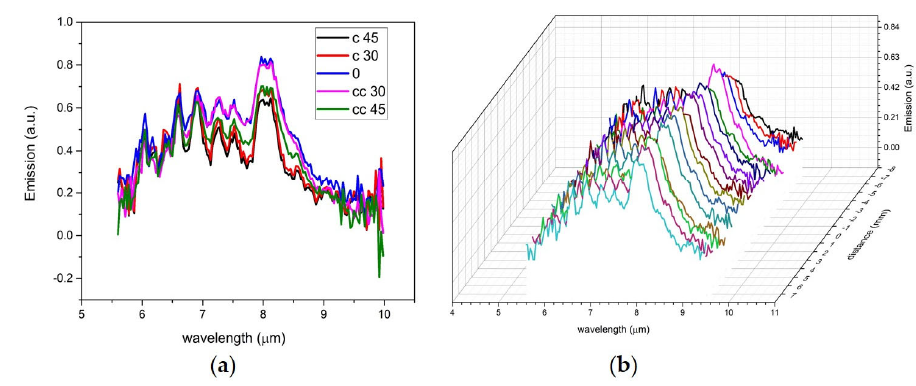
Figure 9. ( a ) LWIR LIBS spectra of acetaminophen at different sampling angles: 0 (parallel to the focal plane of the LWIR collection optics), c 30 (rotated 30° clockwise), c 45 (rotated 45° clockwise), cc 30 (rotated 30° counterclockwise), cc 45 (rotated 45° counterclockwise). ( b ) LWIR LIBS spectra of acetaminophen at different sampling distances. Distance 0 was set at one meter from the front end of the collection optics mirror set.